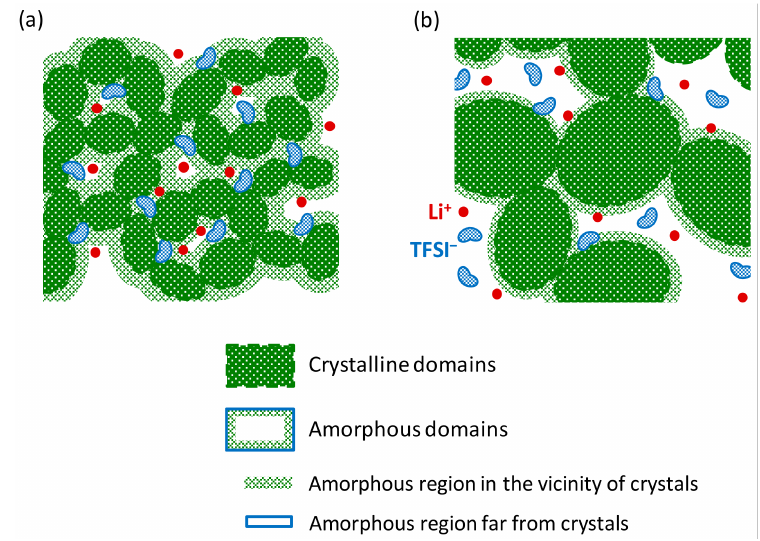
Figure 14. Schematic features of PVDF gels composed of crystalline and amorphous phases with ( a ) smaller crystals formed via the quenching process or via the annealing process and ( b ) larger crystals formed via the annealing process. Reprinted with permission from [14]. Copyright 2020 ACS Publications.